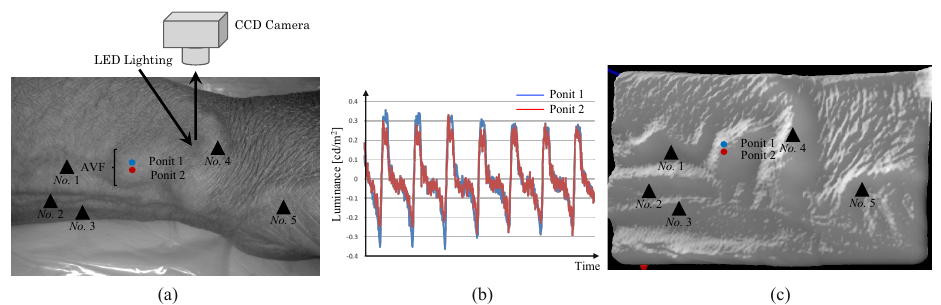
Figure 8. AVF pulse wave measured with blue light. ( a ) Photograph of a left wrist. ( b ) AVF pulse wave measured at the two points close to the anastomosis. The low- and high-cutoff frequencies of band pass filter were 1Hz and 10Hz, respectively. Because the similar waveforms are observed at different points, the measured data is not sensitive to observation points. ( c ) Three-dimensional image by the photometric method with blue light. As compared with the photo shown in ( a ), good agreement is confirmed, which means that the three-dimensional image based on the luminance is efficient to represent the AVF form.